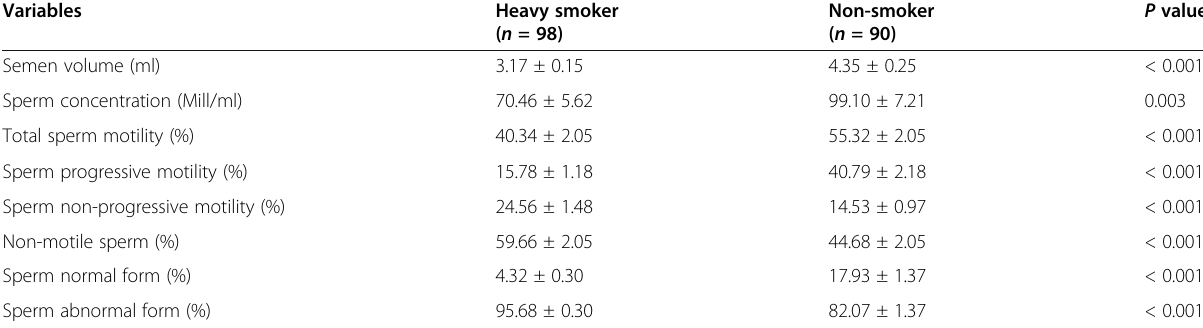
Table 2 Descriptive characteristics of heavy smokers compared to non-smokers ( n = 188) Variables